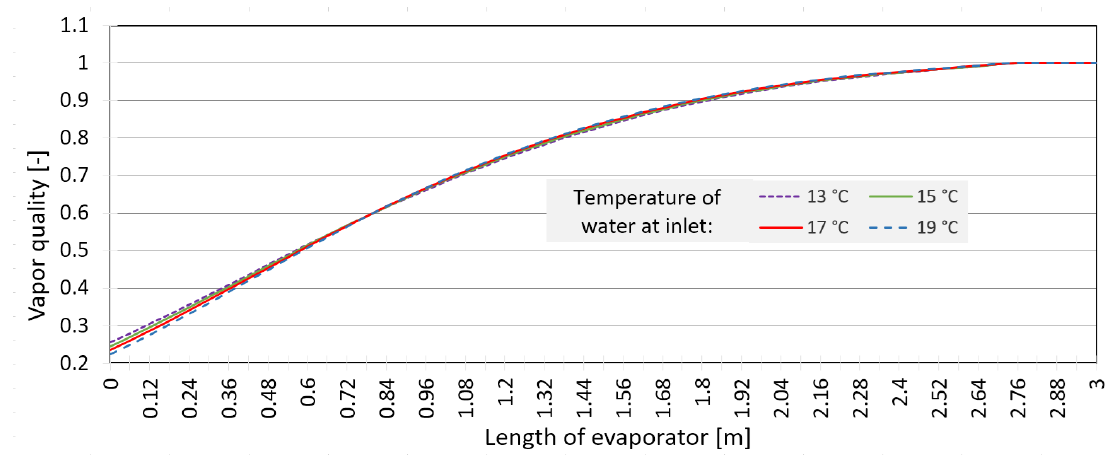
Figure 4. Temperature variation of the tube wall.